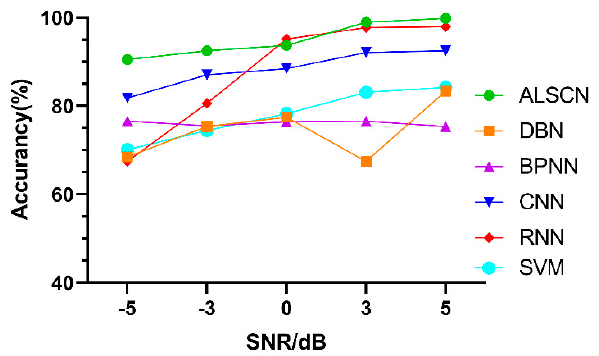
Figure 14. Test accuracy of different models under different signal to noise ratio (SNR) on CWRU.